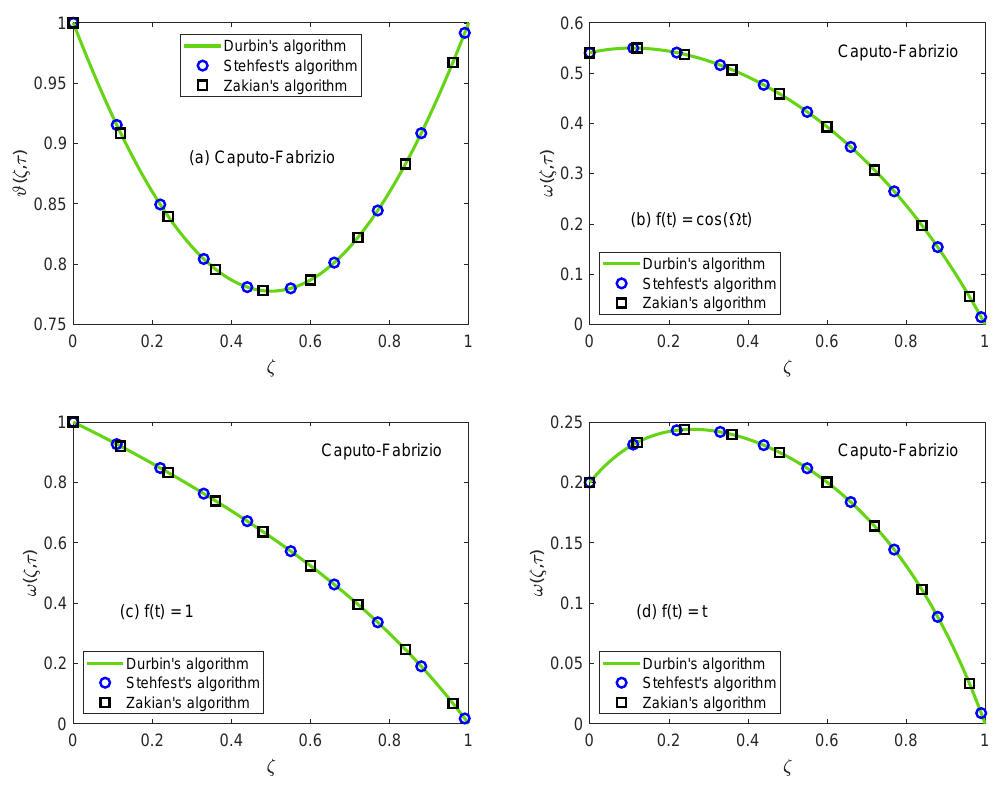
Figure 19. Validation of temperature and velocity fields developed through CF